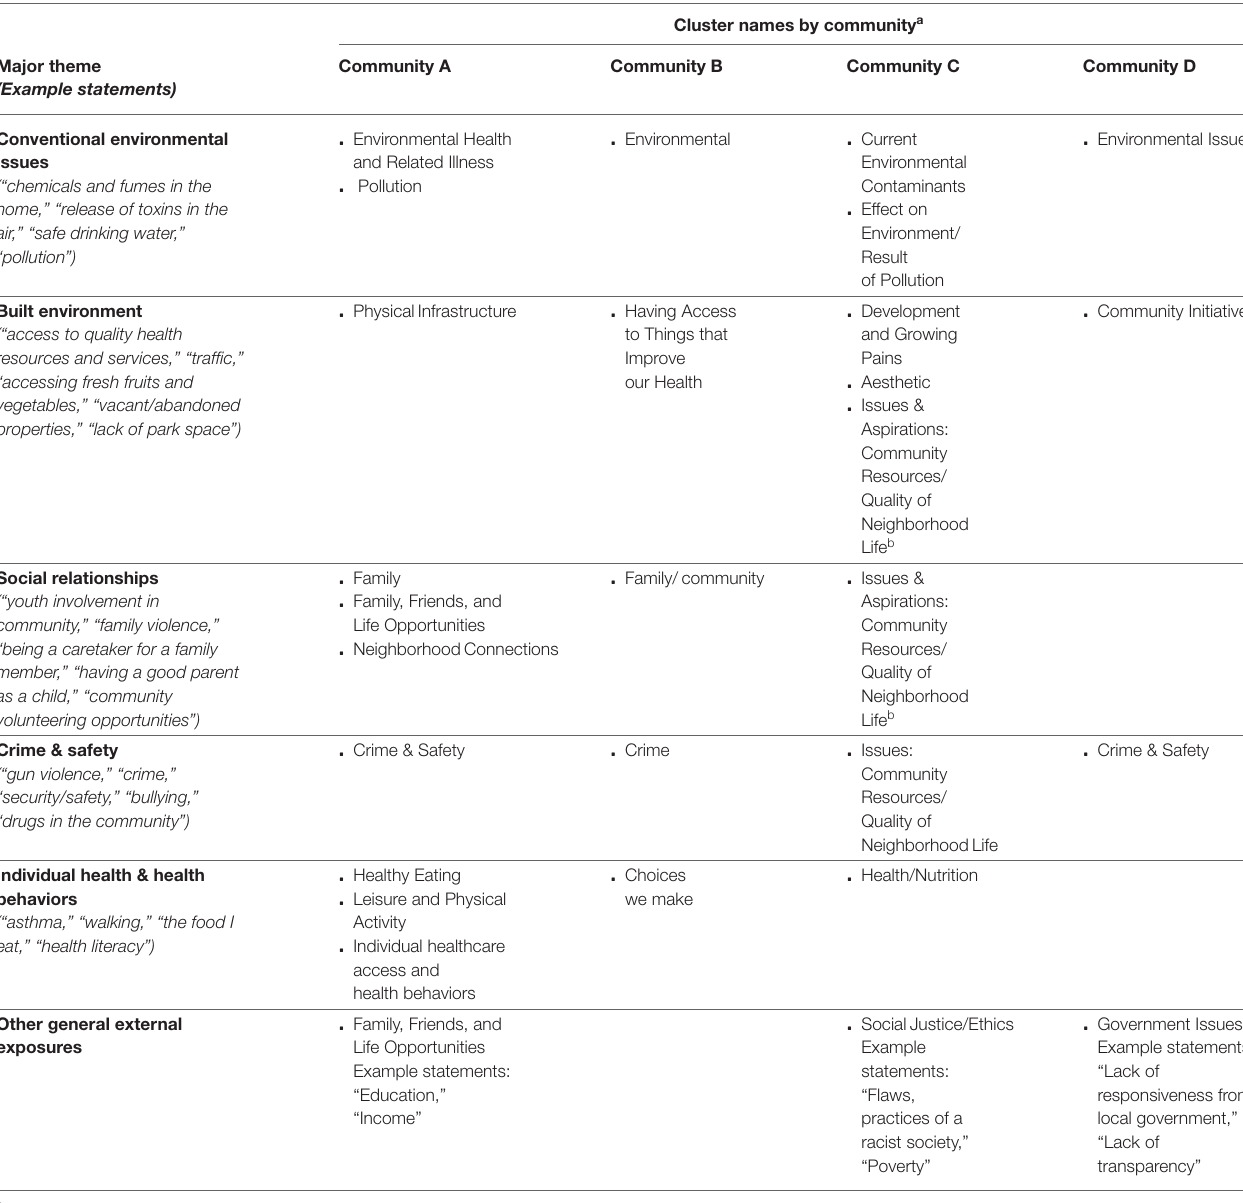
TABLE 5 | Concept mapping clusters by community and